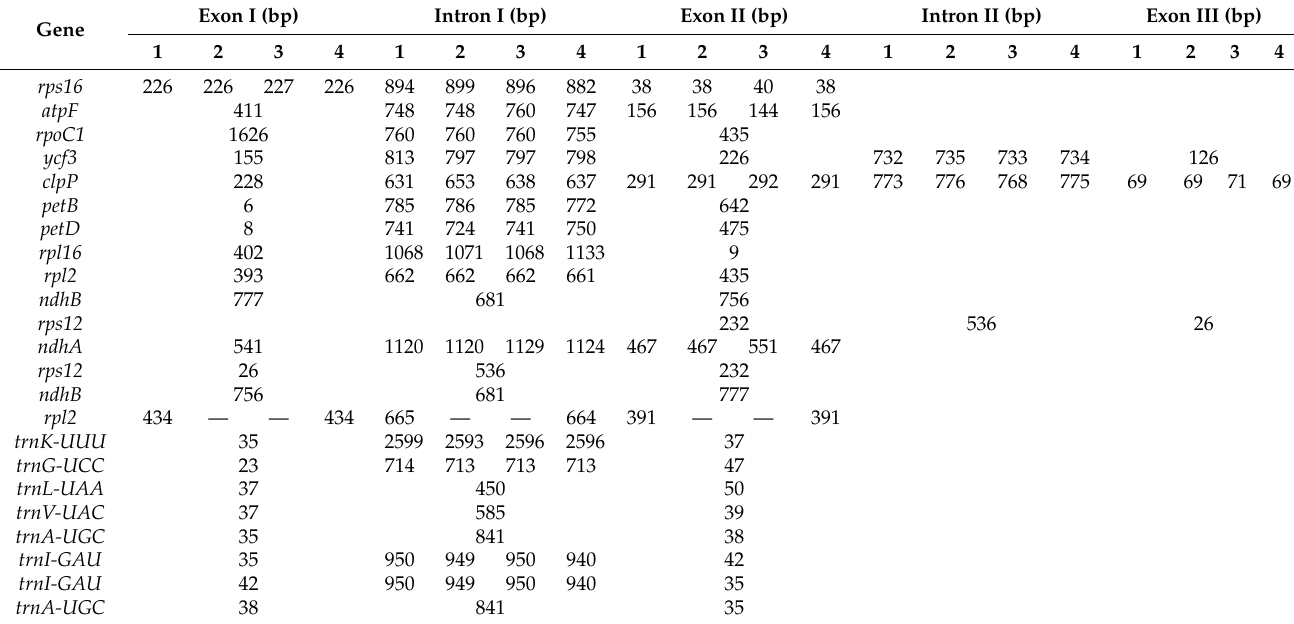
Table 3. Lengths of exons and introns of coding genes in the complete chloroplast genomes of four R. chinensis accessions.